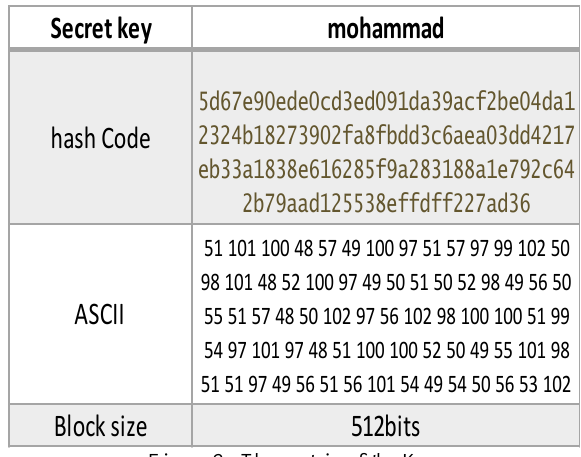
Figure 2. The matrix of the Keys